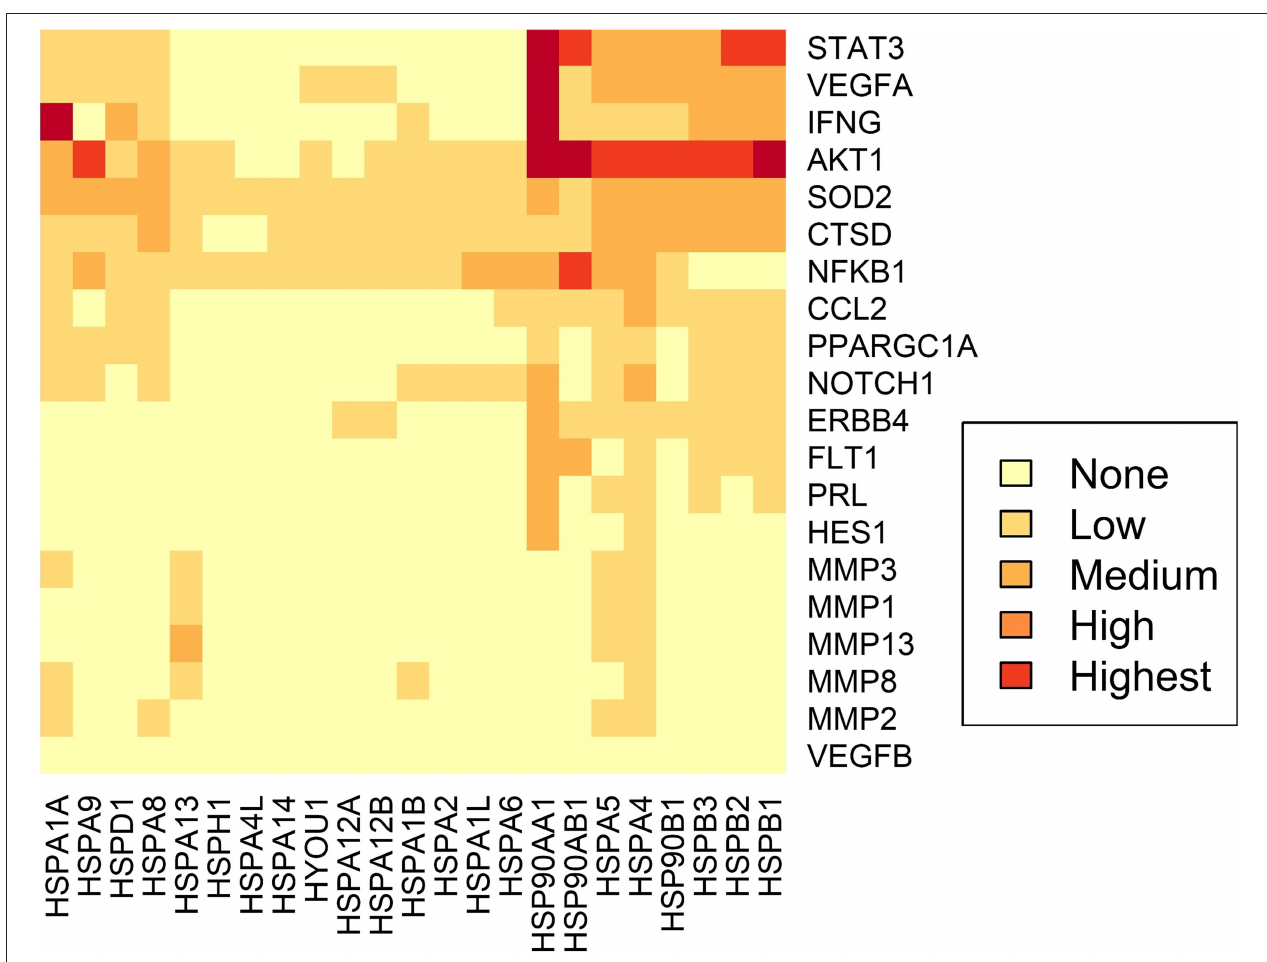
FIGURE 4 | Predicted interactome of several Hsps with PPCM proteins. The heat map shows the interaction of PPCM pathogenesis proteins with Hsp70, Hsp90 and sHsp group members. demonstrated potential roles of Hsps in cardiac inflammatory pathways in response to myocarditis (122, 123) and myocardial injury (discussed